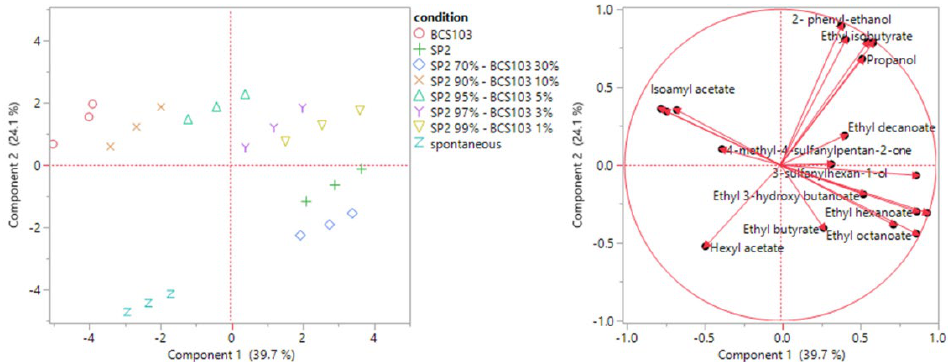
Figure 3. Principal component analysis of 20 volatile compounds of Sauvignon blanc wines fermented with monocultures of S. bayanus (BCS103) and S. pastorianus (SP2), mixed cultures of both species in different inoculation ratio as well as the spontaneous fermentation condition.